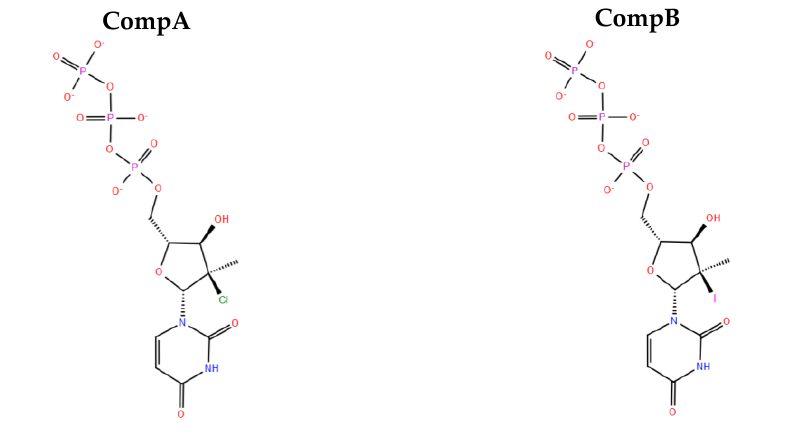
Figure 11. The designed GS − 461203 analogues.